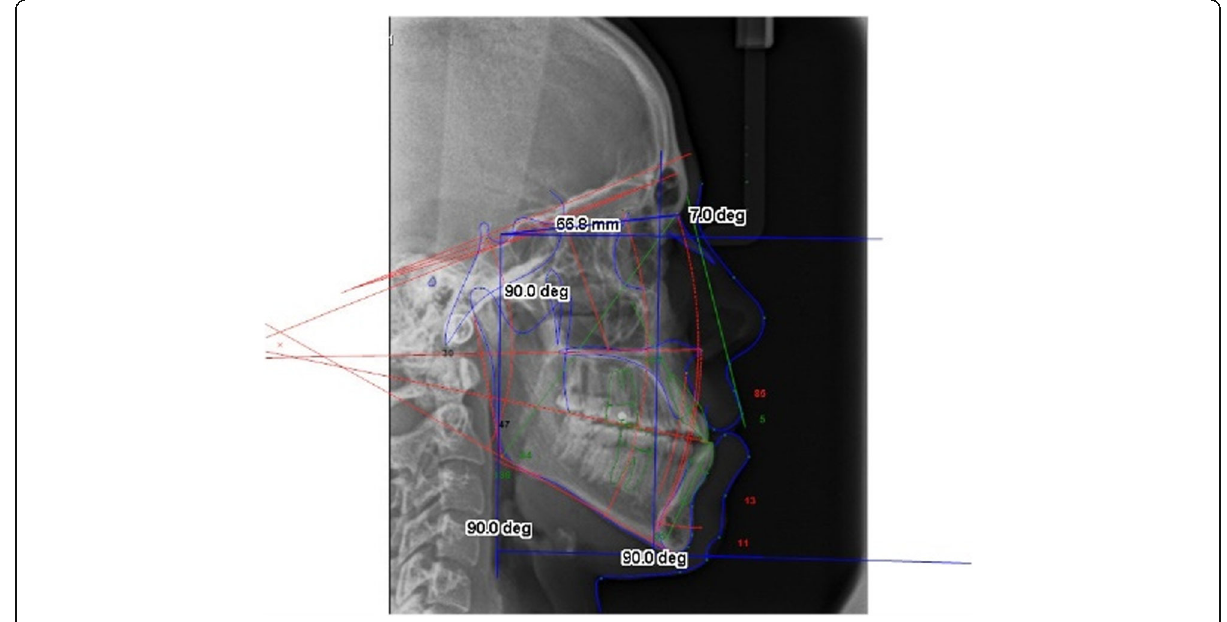
Fig. 1 Image on Dolphin software depicting the posterior arc and anterior arc intersection with the mandibular